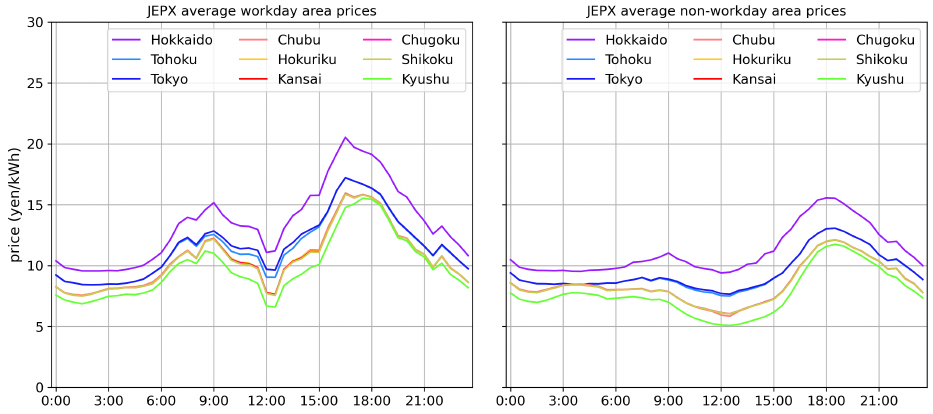
Figure 3. Average area prices for the JEPX for the period spanning 1 April 2016 to 31 March 2022. On the spatial axis, prices are seen to be different for different areas. Generally, prices are observed to be higher in the eastern regions of Hokkaido, Tohoku, and Tokyo and